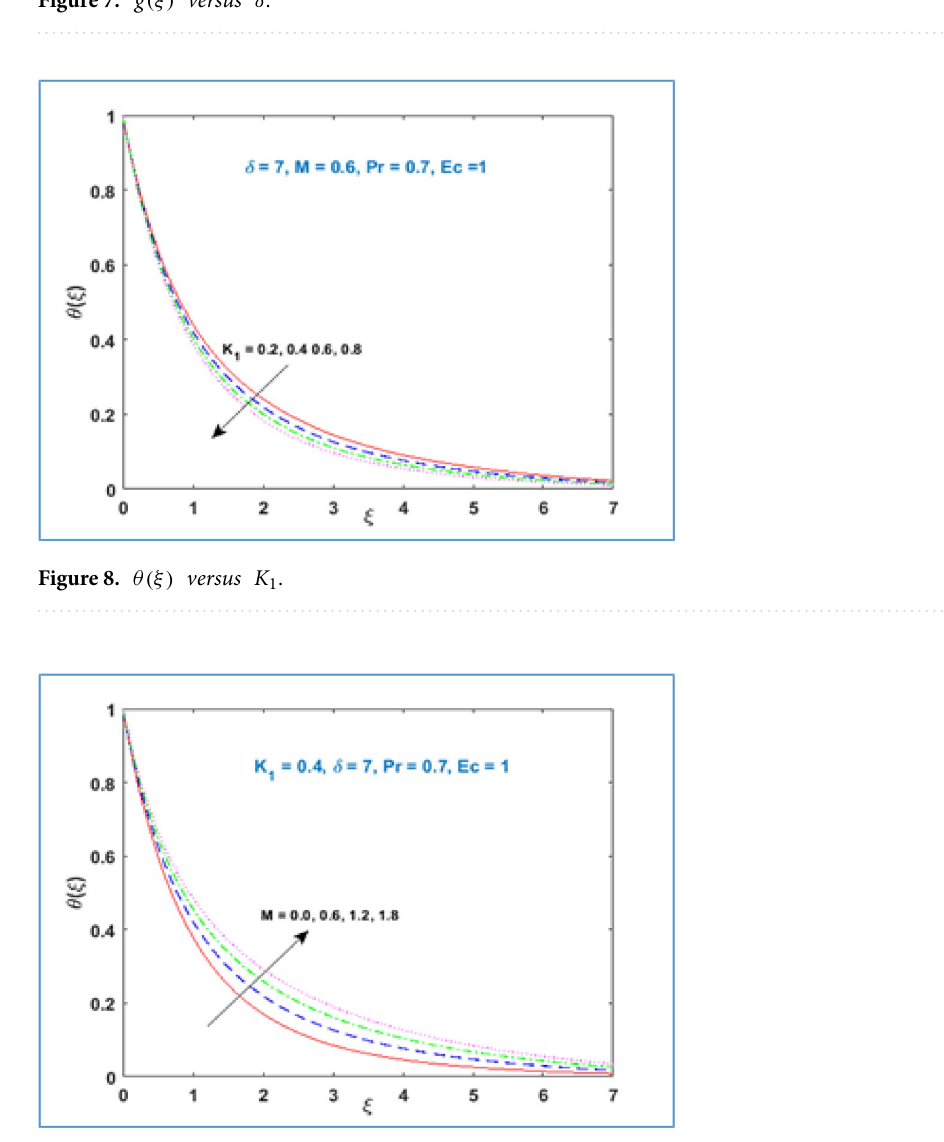
Figure 7. g (ξ) versus δ .